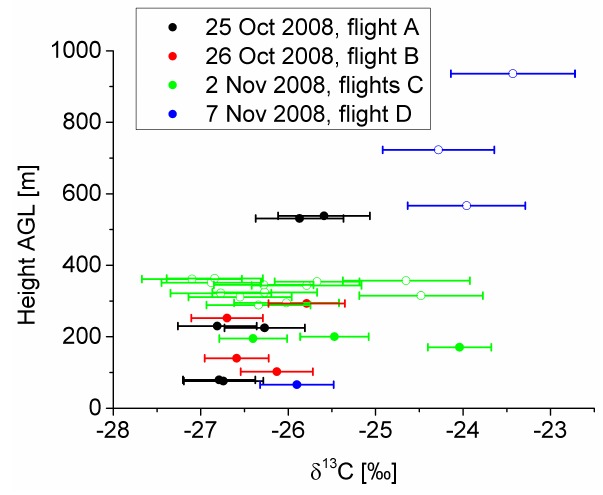
Fig. 14. Vertical profiles (height above ground level) of toluene δ 13 C values; data from the PBL are shown as filled circles, data from the LFT as open circles.